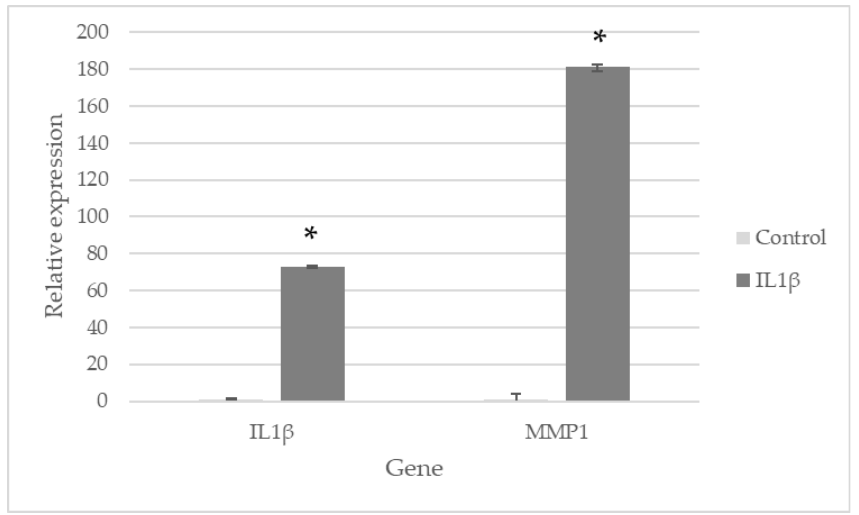
Figure 4. Relative gene expression (expressed as fold change) of IL1 β -activated NHAC-kn in monolayers (vs. cells incubated without IL1 β ) n = 4. Mean values and standard error are given. *: p ≤ 0.05.